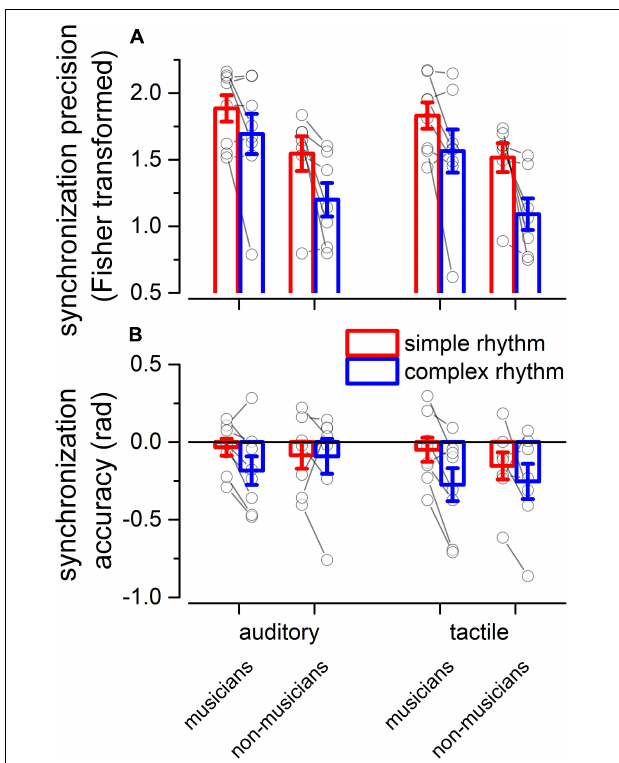
FIGURE 3 | Experiment 2: reproduction quality. (A) grand-average synchronization precision for simple (red) and complex rhythms (blue) for all the modality conditions and expertise. Dots indicate individual data, error bar indicates ± 1 S.E.M. (B) Same as (A) but for synchronization accuracy.